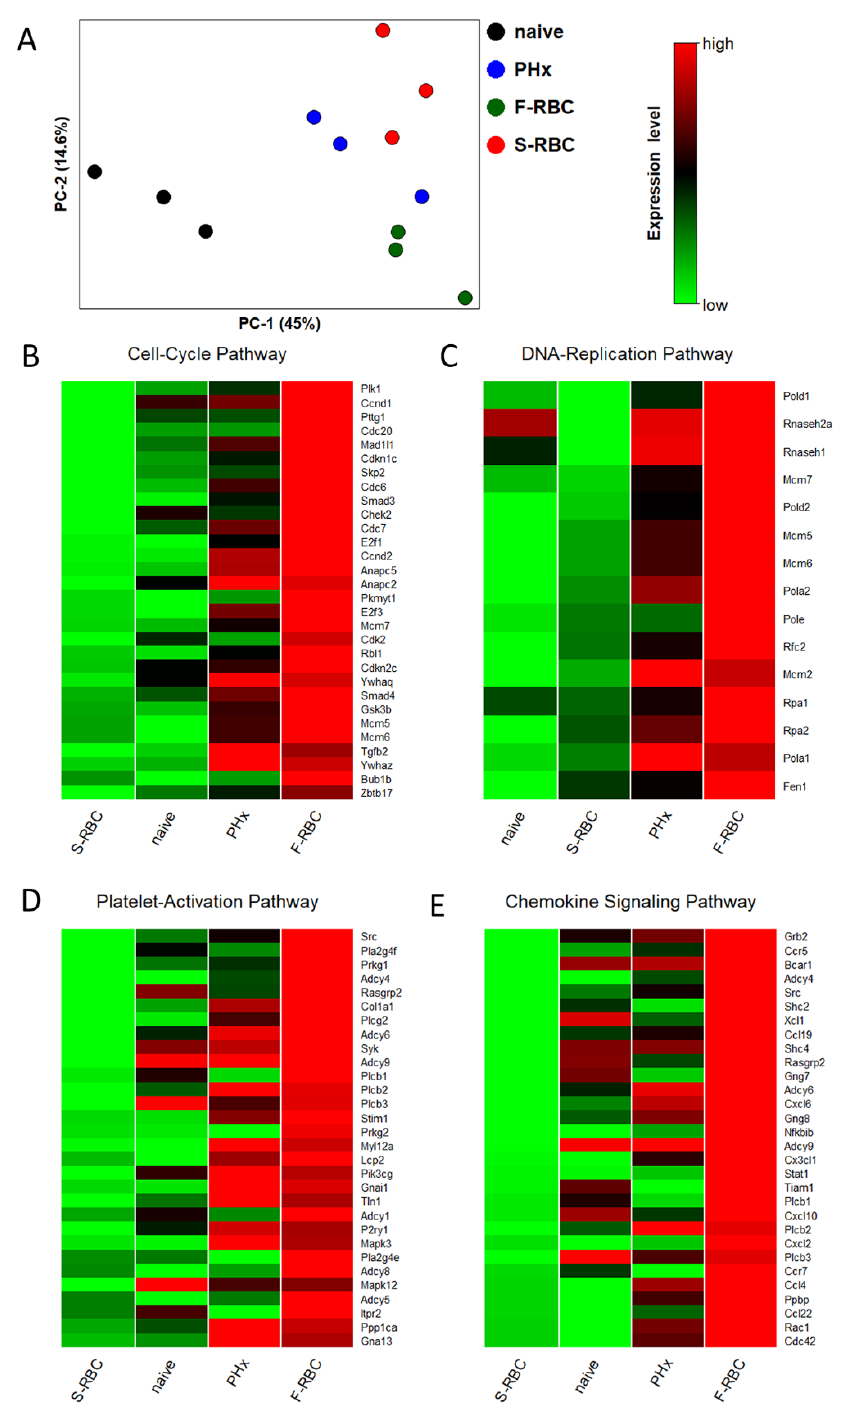
Figure 3. Effect of F-RBC vs. S-RBC resuscitation on cell cycle and inflammatory pathway genes. ( A ) Principal Component Analysis (PCA) plot showing RNA-Seq samples analyzed by treatment groups. PHx substantially alters gene expression, as demonstrated by PC-1. PCA analysis confirms that the three samples of each group cluster together and that there is a significant difference between the RBC-resuscitated groups. ( B – E ) Significant differences are observed between resuscitation with F-RBCs as compared to S-RBC in several pathways. The top 30 differentially expressed genes between groups receiving F-RBC resuscitation and S-RBC resuscitation are visualized as heat maps of gene expression, where red indicates upregulated genes, and green indicates downregulated genes.